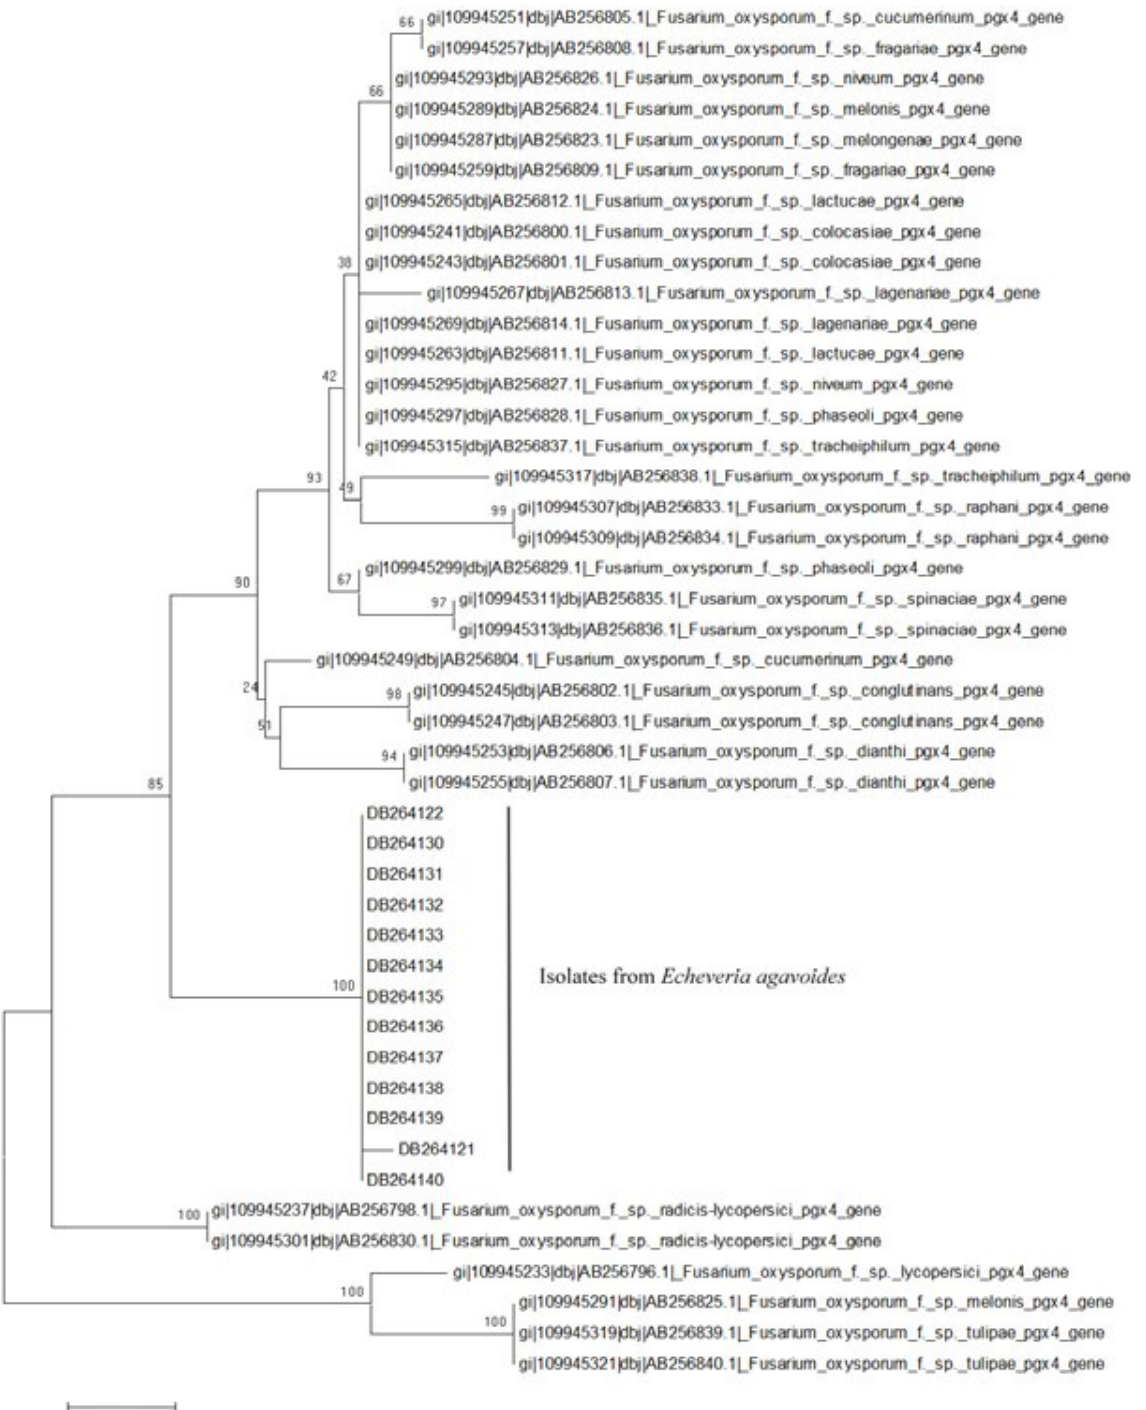
Figure 5. Phylogenetic tree based on Pgx4 gene sequences, built by Mega5 software with the Neighbour joining method with 1,000 bootstrapping